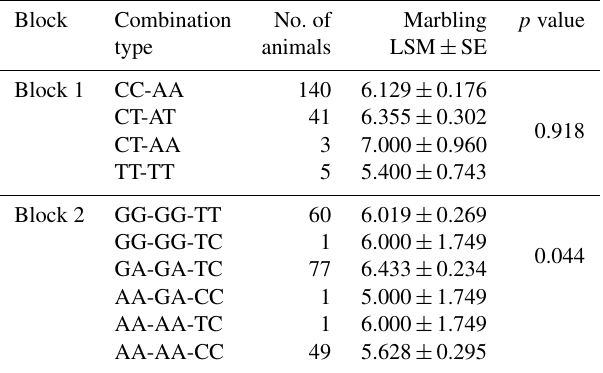
Table 2. Effect of combination SNPs on marbling scores in Korean cattle steer ( n =